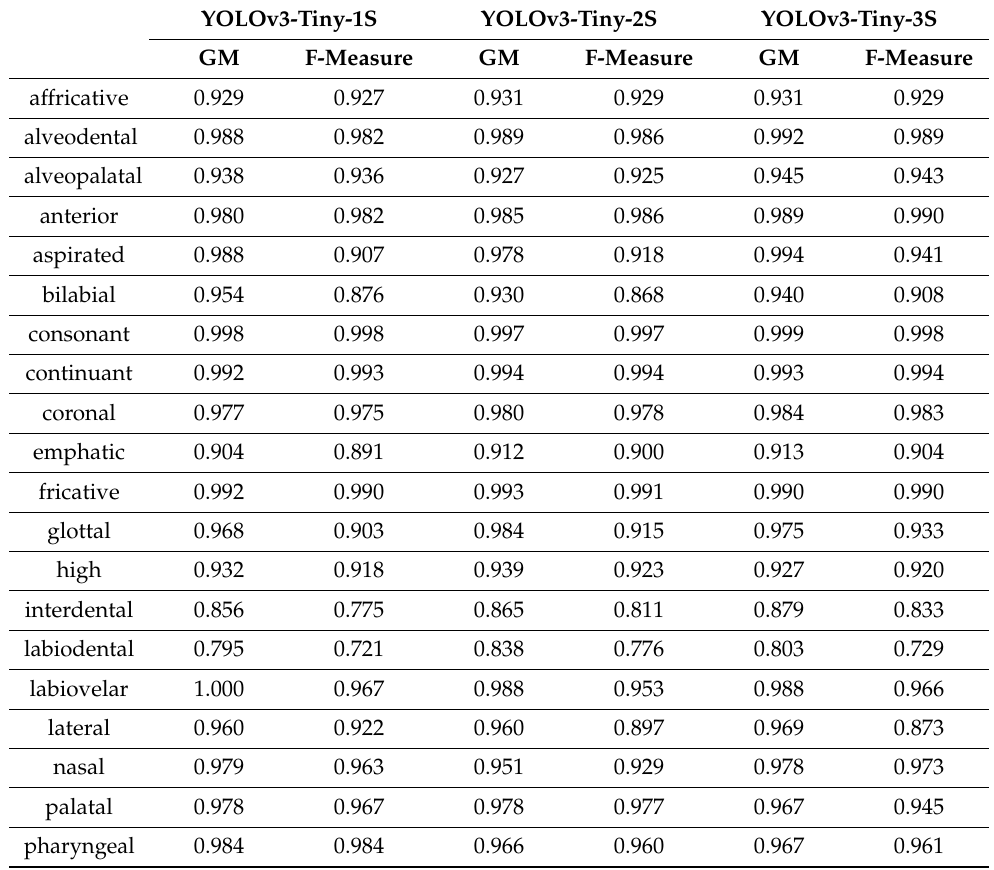
Table 4. Performance metrics of the proposed system AFD-Obj using three models (i.e., YOLOv3- tiny-1S, YOLOv3-tiny-2S, and YOLOv3-tiny-3S) for the Arabic